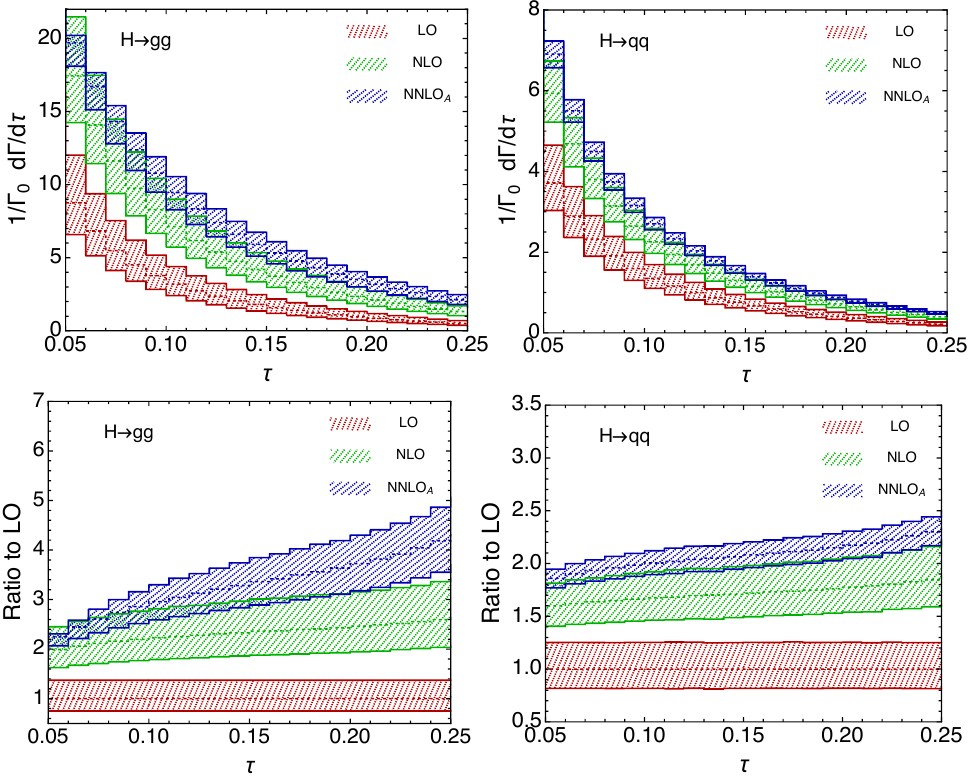
Figure 8 . Thrust distributions at LO, NLO and approximate NNLO.